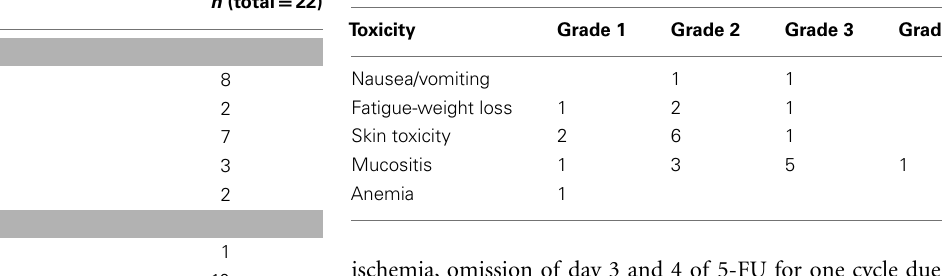
Table 6 |Toxicity in administration of concurrent cetuximab